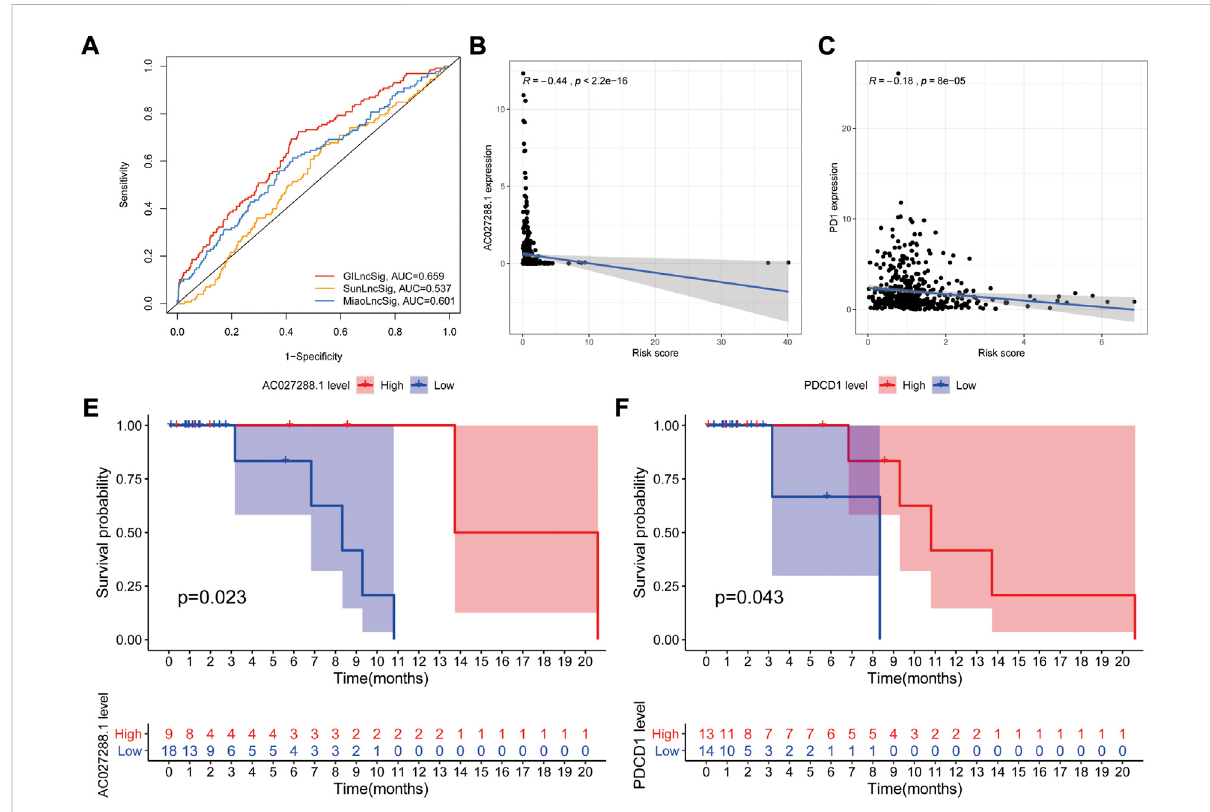
FIGURE 10 Evaluation of lncRNA signature performance. (A) ROC analyses for GIrLncSig, SunGIrLncSig and MiaoGIrLncSig. (B) Expression analysis of AC027288.1 in high groups. (C) Expression analysis of PD1 in high groups. (E – F) Independent validation of the GlrLncRNA. Kaplan-Meier curves showed that OS was worse for patients with low expression levels. GIrLncRNAs, genomic instability-related lncRNAs signature; ROC, receiver operating characteristic; SunGIrLncSig, Sun lncRNA signature; MiaoGIrLncSig, Miao lncRNA signature; OS, overall